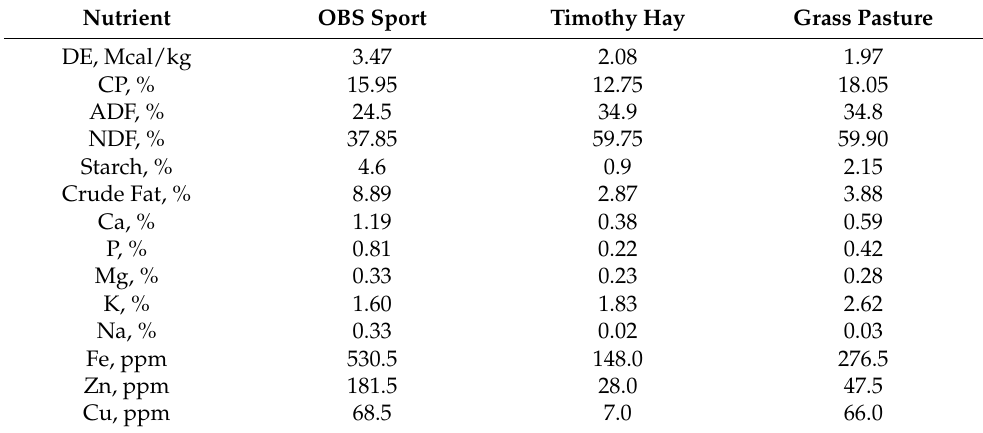
Table 1. Nutrient composition of OBS sport feed, timothy hay, and Bahiagrass pasture offered to horses. All nutrients are presented on a 100% dry matter (DM)